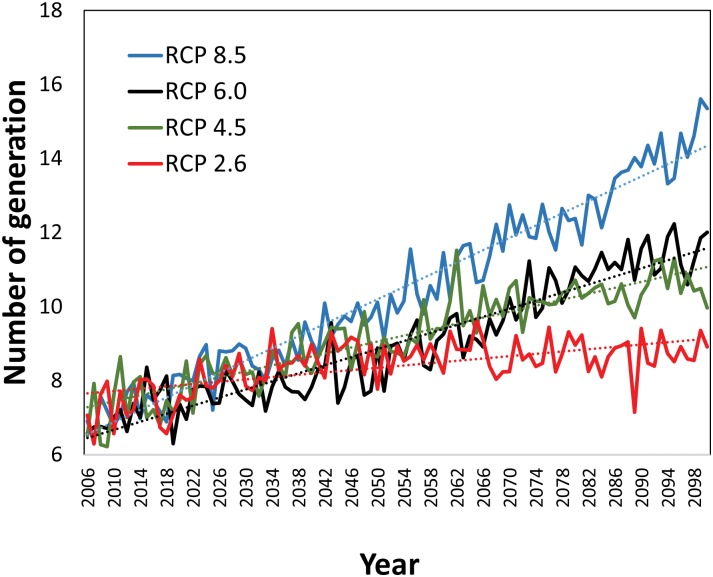
Temporal changes in the voltinism of C. krombeini in West Virginia and its surrounding regions (37–41°N and 77–83°W; see the boxed area in Fig 5A) in 2006–2100 under the four climate scenarios of RCP 2.6 (y = 0.0157x + 7.6399, P < 0.01), RCP 4.5 (y = 0.0403x + 7.241, P < 0.01), RCP 6.0 (y = 0.0545x + 6.398, P < 0.01), and RCP 8.5 (y = 0.0829x + 6.466, P < 0.01).